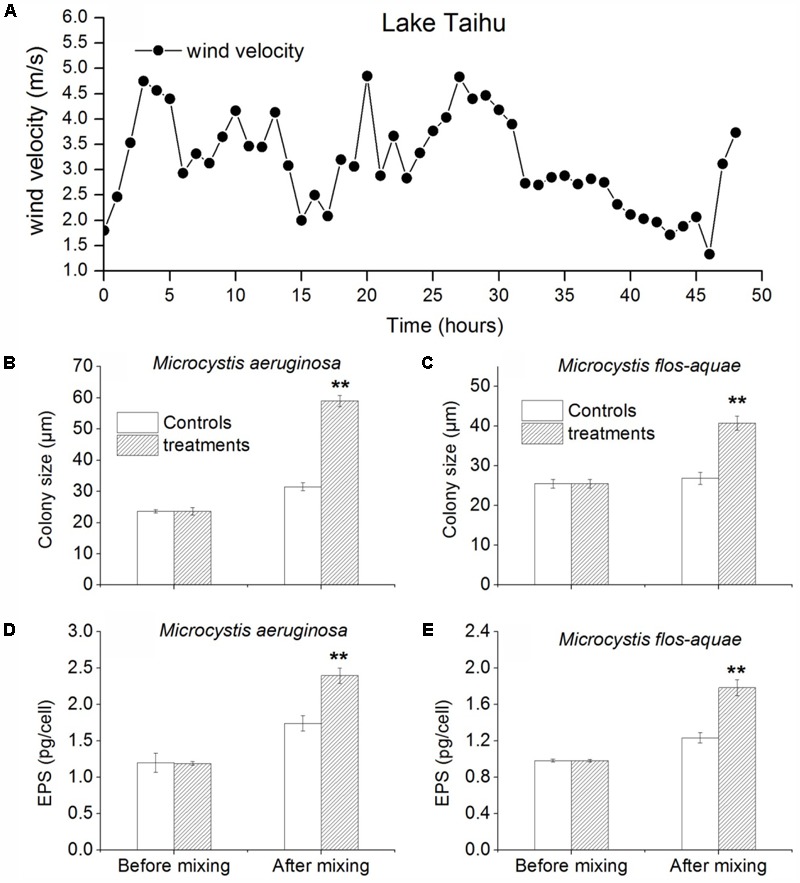
In situ experiments about mixing effect on colony size and EPS (extracellular polysaccharide (EPS)) concentrations, and colony size of Microcystis at the pier end of TLLER. (A) Wind speed during experiment. (B) Colony size of Microcystis aeruginosa in control and treatment. (C) Colony size of M. flos-aquae in control and treatment. (D) EPS concentration of M. aeruginosa in control and treatment. (E) EPS concentration of M. flos-aquae in control and treatment; error bars was indicated by ± SD ∗p < 0.05, ∗∗p < 0.01, n = 3).